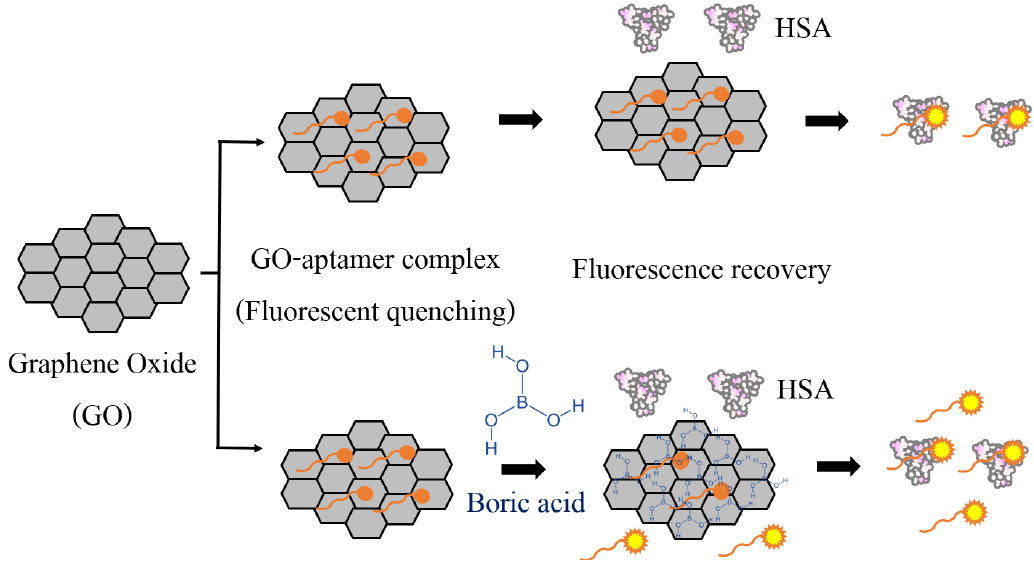
Figure 4. Schematic illustration of the graphene oxide-based fluorescent detection of human serum albumin (HSA) in boric acid-preserved urine samples.